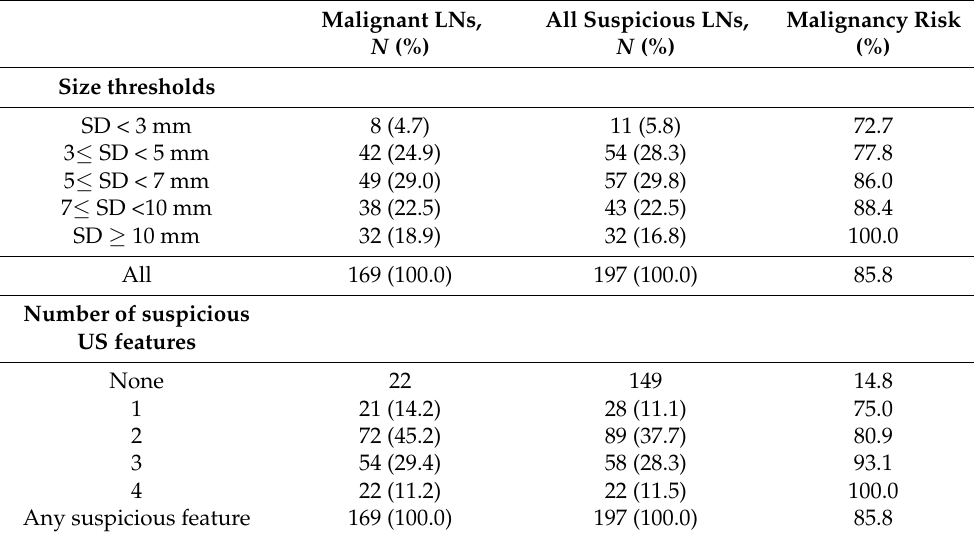
Table 4. Malignancy risk of US suspicious LNs according to size thresholds and number of suspicious US features.